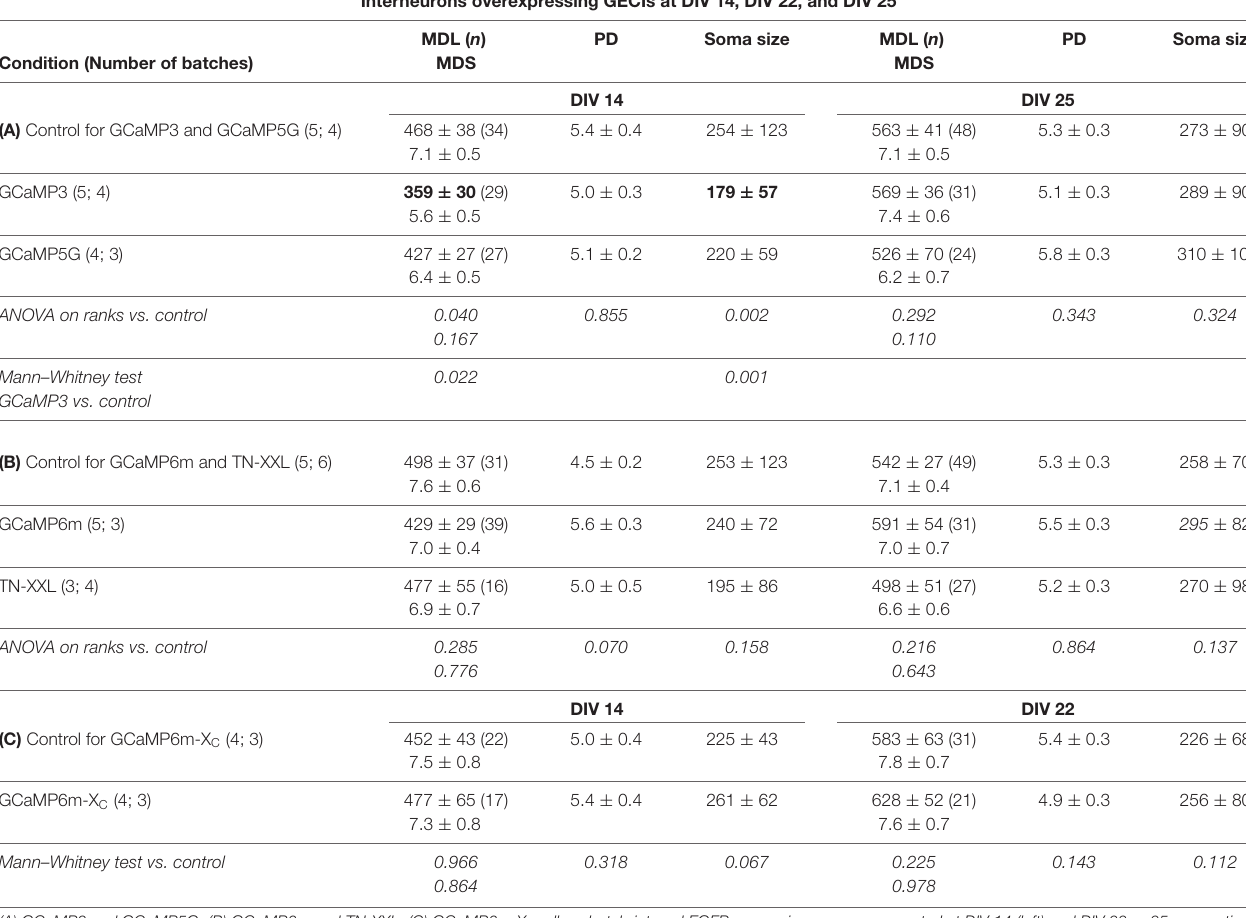
TABLE 5 | Measures of dendrites of multipolar